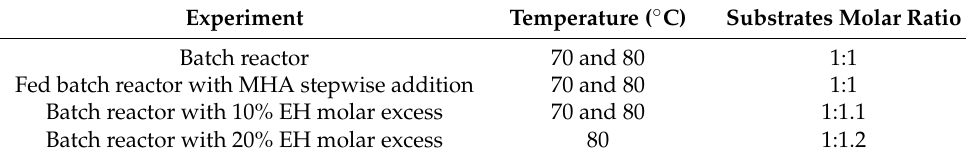
Table 1. Experimental conditions for the assays performed in the batch reactor. Experiment Temperature ( ◦ C) Substrates Molar Ratio Batch